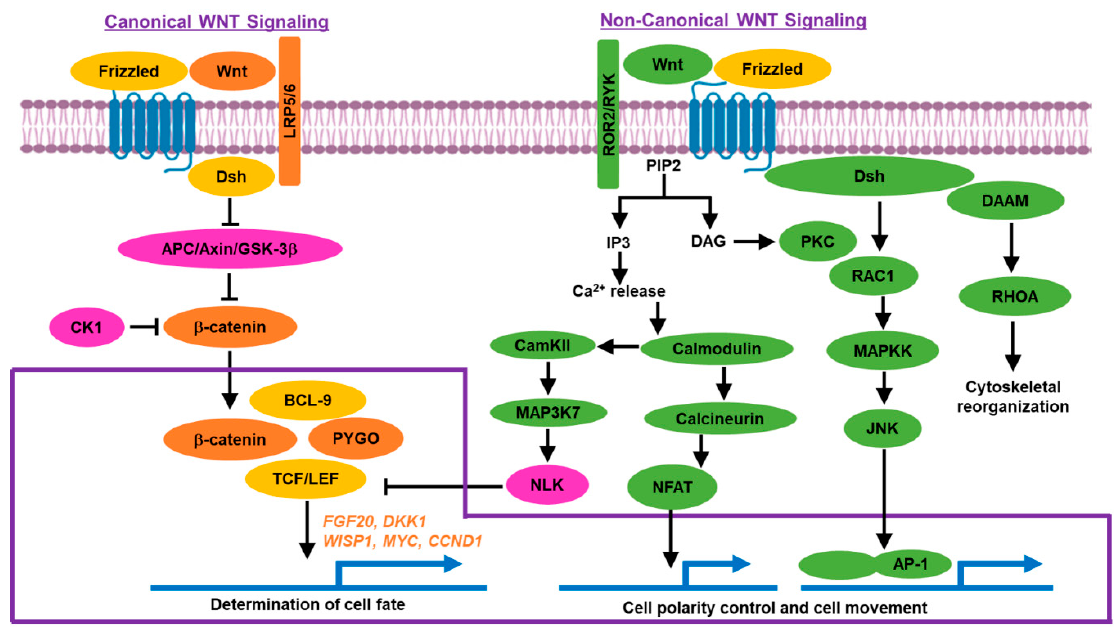
Figure 1. Canonical ( β -catenin dependent) and non-canonical ( β -catenin independent) Wnt signaling pathways.